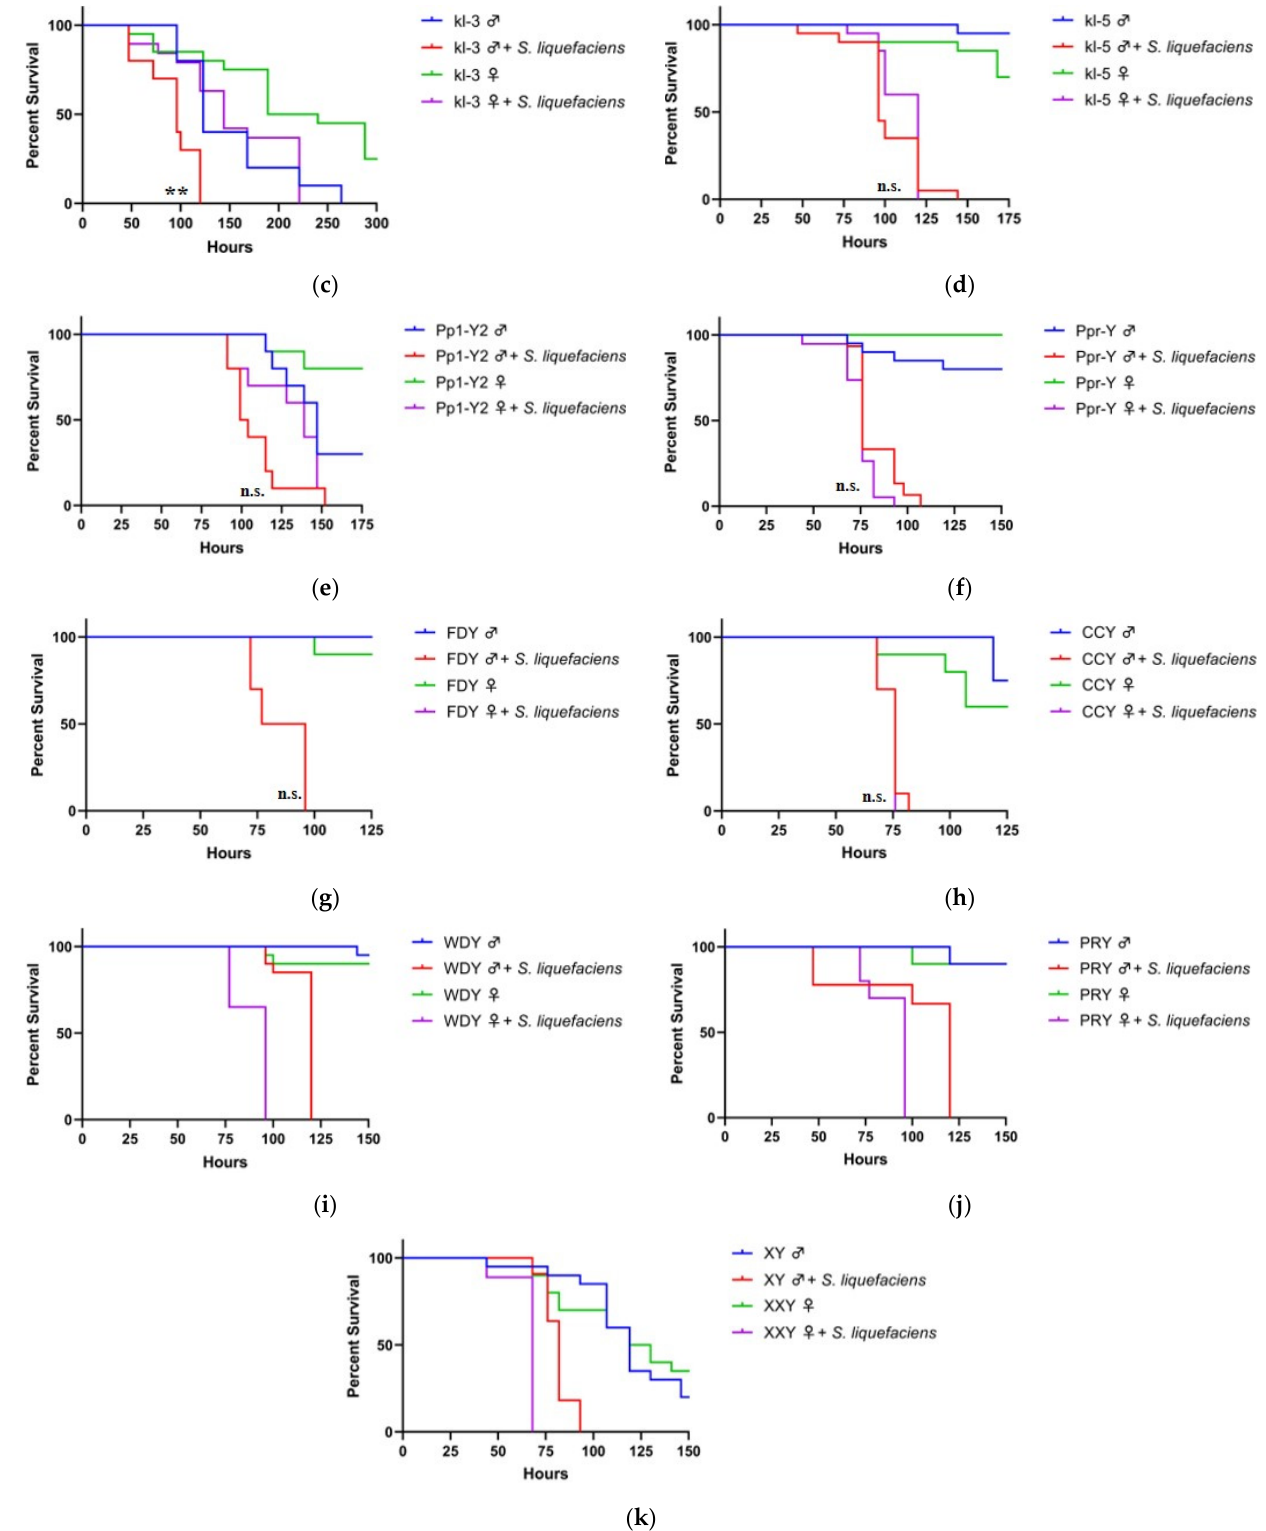
Figure 2. Loss of function of multiple Y-genes increase the sensitivity of males to bacterial infection. Wild-type (WT), loss of function Y-mutant males and XXY females (ABO-X2) were orally exposed to a 50 mM sucrose solution containing Serratia liquefaciens. For experiments with wild-type flies, Oregon-R strain was used ( a ). For mutant fly strain experiments involving loss of function of Y-genes, females are wild-type ( b – j ). In the case of XXY females, males are wild-type ( k ). Each condition contains ten flies. Vials are incubated at 30 ◦ C and checked a minimum of twice per day for fly survival (**, p < 0.01; ****, p <